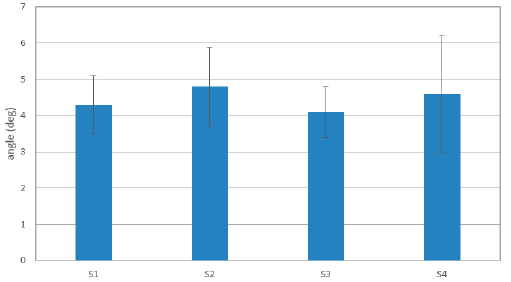
Figure 21. Average errors between detected motion and predicted motion in the second level experiment.